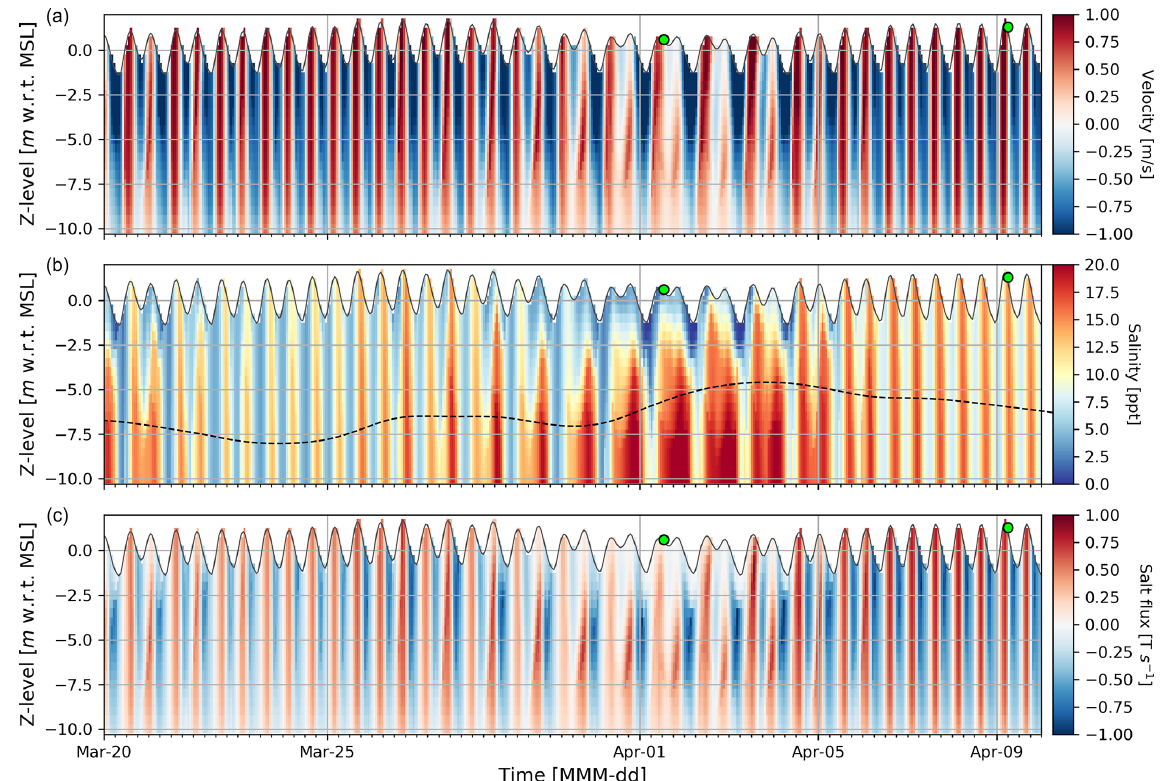
Figure 9. Modelled temporal stationary estuarine variability at a point 15km from the sea in the Dinh An channel in period 2 (field cam- paign). (a) Velocity profile in time with the green circles marking the measurement locations of the field campaign along the Dinh AN channel. (b) Salinity profile in time (15km from the sea) and depth-averaged salinity at Cau Quan as a black dashed line scaled with the right y axis (the right y axis shares the labels with the colour bar). (c) Salt flux (product of salinity and velocity in a grid cell at a point along the